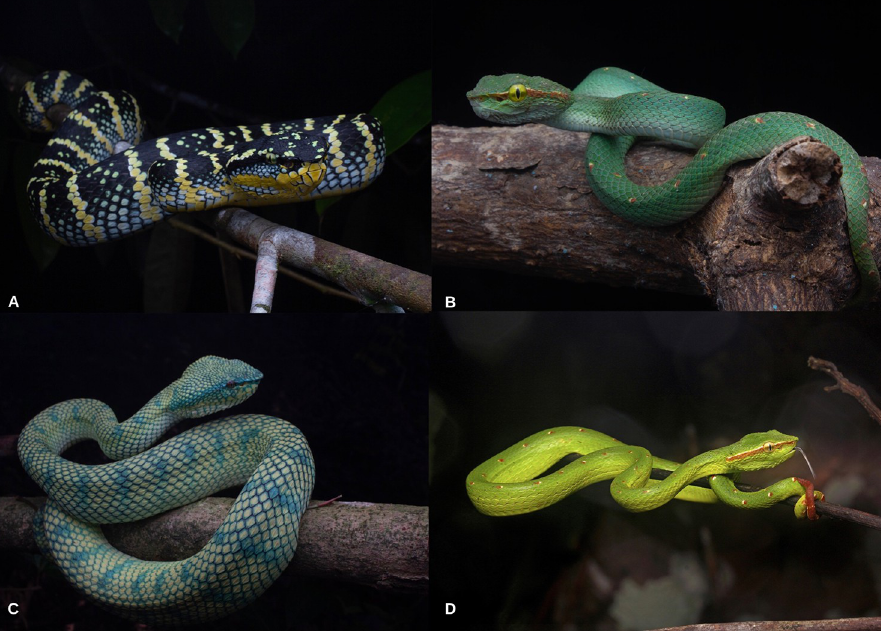
Fig 1. The morphological differences between male and female Tropidolaemus wagleri and Tropidolaemus subannulatus . (A) Adult female Tropidolaemus wagleri . Image credit : M . K . Arif (B) Adult male Tropidolaemus wagleri . Image credit : M . K . Arif (C) Adult female Tropidolaemus subannulatus . Image credit : M . K . Arif (D) Adult male Tropidolaemus subannulatus . Image credit : E . W . Teo